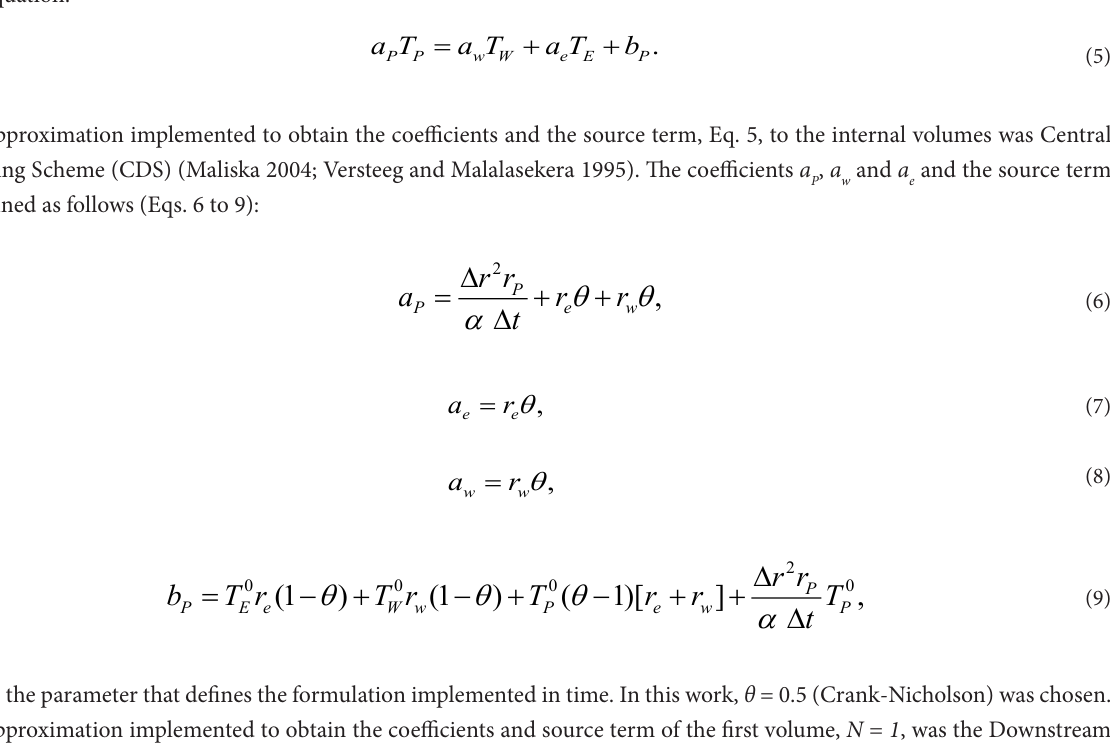
Figure 2. Uniform one-dimensional mesh.